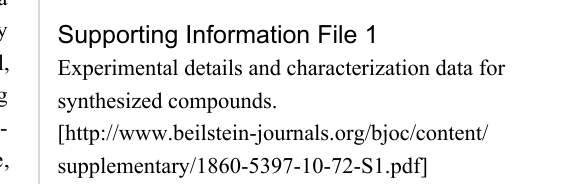
trum of the (2 E ,4 E )-configured 2,4-dien-1-ol 23 (Figure 1), and its gas-chromatographic properties perfectly matched the corresponding data of the natural product B (linear retention index on DB1 = 1766 and a Stabilwax = 2317)